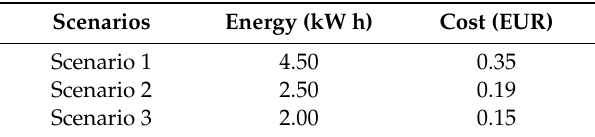
Table 6. Comparison of the average daily energy consumption and cost management for a single user within three